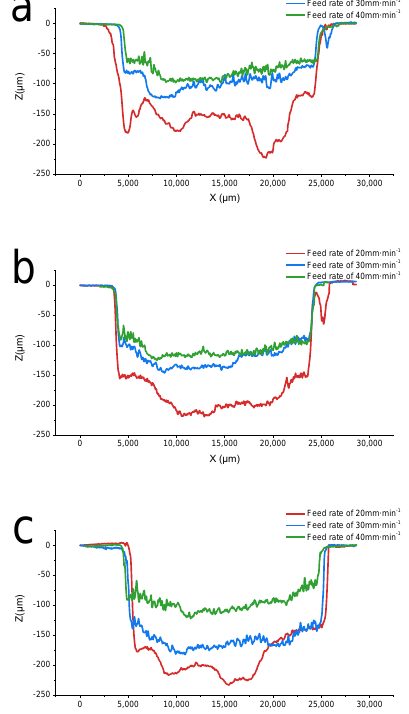
Figure 6. Horizontal profile at different feed rates. ( a ) Voltage = 40 V, ( b ) voltage = 50 V, and ( c ) voltage = 60 V. When feed rate = 20 mm·min −1 (red), the groove depth reaches the maximum, but the flatness of the groove is the worst. When feed rate = 40 mm·min −1 (green), the flatness is the best. The result of feed rate = 30 mm·min −1 (blue) is between 20 and 40, both for groove depth and flatness .